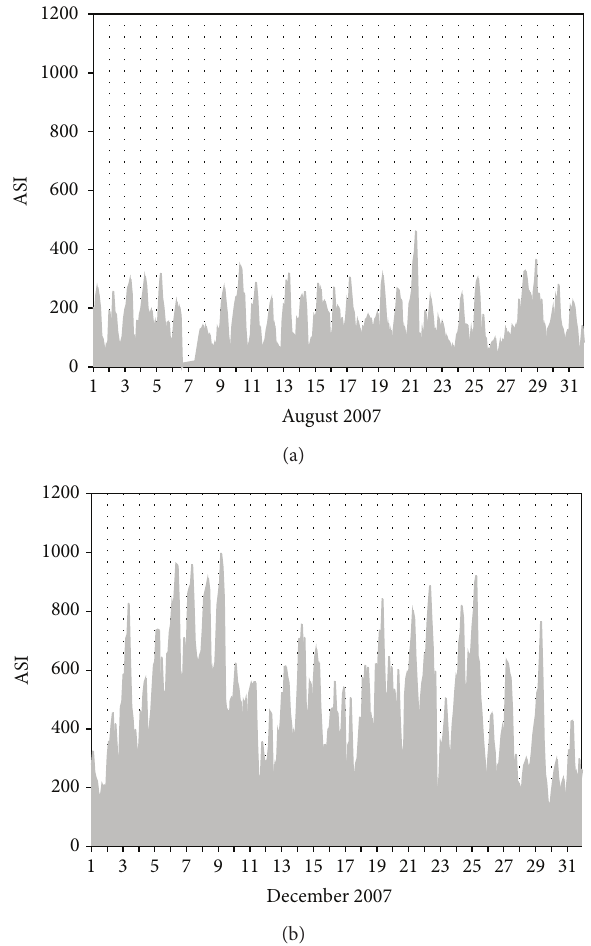
Figure 3: Temporal trend of ASI in August and December, 2007, (data missing on August 6-7 for maintenance of the